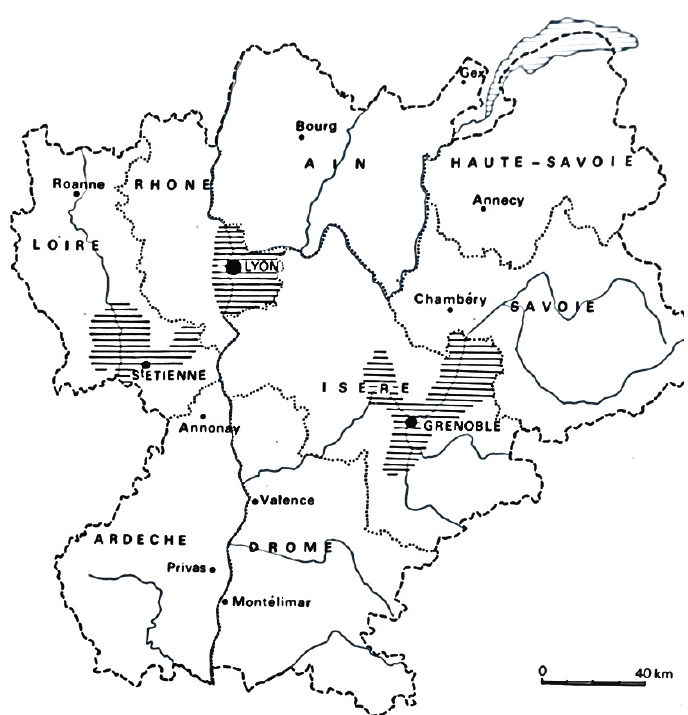
Figure 2. Map of the regional context, including the hatched areas covered by the SDAU Lyon–Saint‐Étienne–Grenoble. Source: OREAM